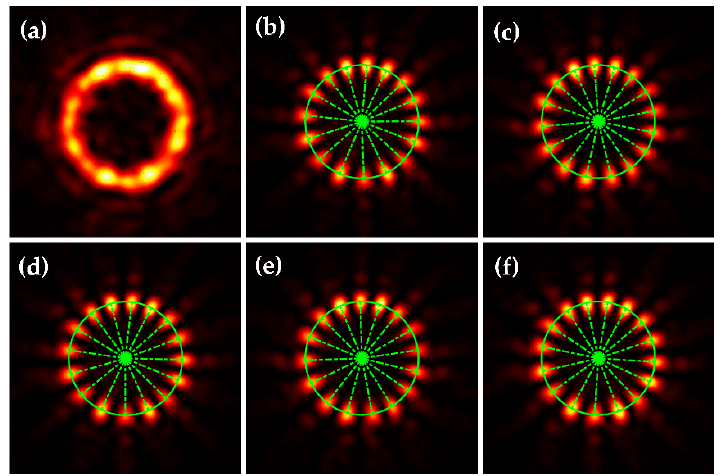
Figure 4. ( a ) The generated vector beam for l = 8. ( b – f ) The petal-like intensity patterns after the P 2 with the orientation of 0°, 80°, 160°, 240°, and 320°, respectively.